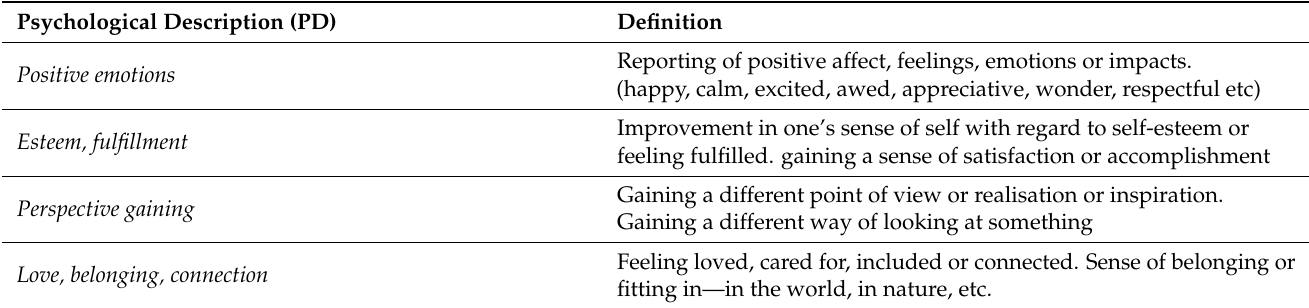
Table 2. Psychological Descriptions and